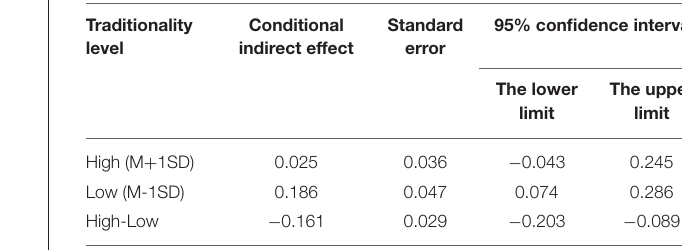
TABLE 4 | Results of moderated mediating effect